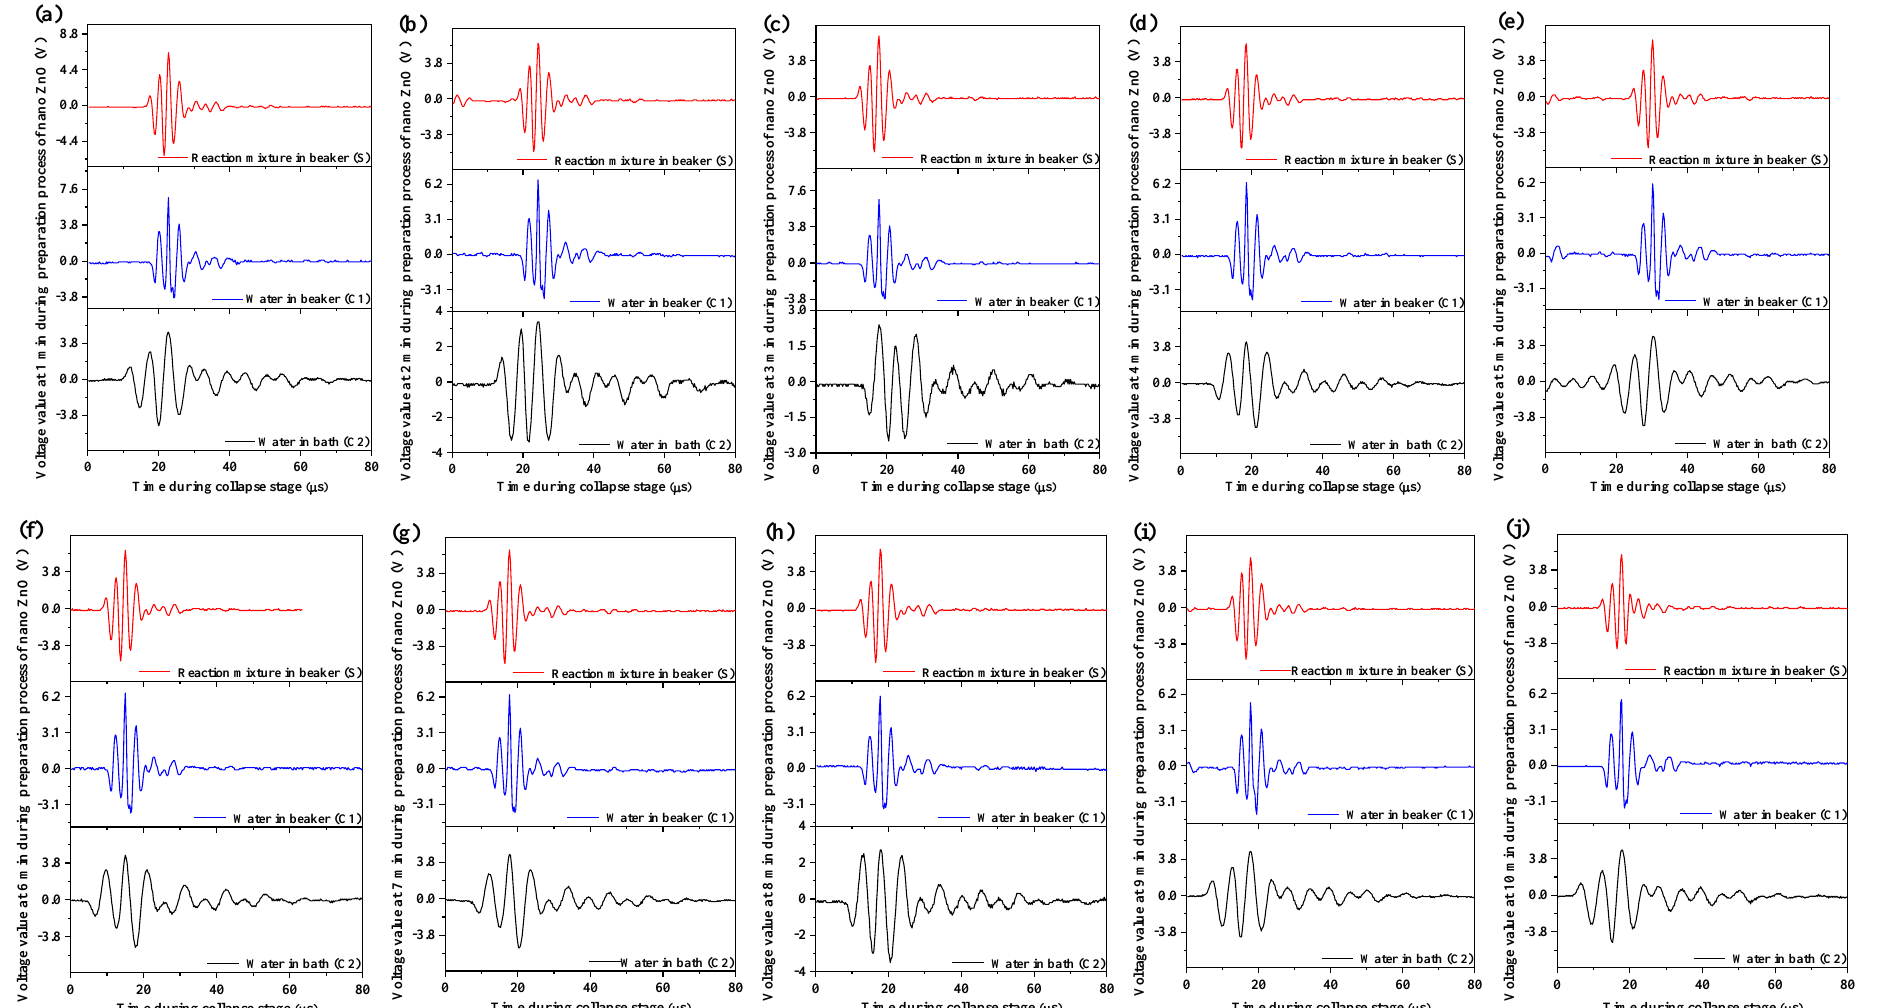
Figure 6. Waveforms at one time of collapse stage acquired every 1 min during ultrasound-assisted synthesis of nano-ZnO. ( a ) 1 min, ( b ) 2 min, ( c ) 3 min, ( d ) 4 min, ( e ) 5 min, ( f ) 6 min, ( g ) 7 min, ( h ) 8 min, ( i ) 9 min, ( j ) 10 min.